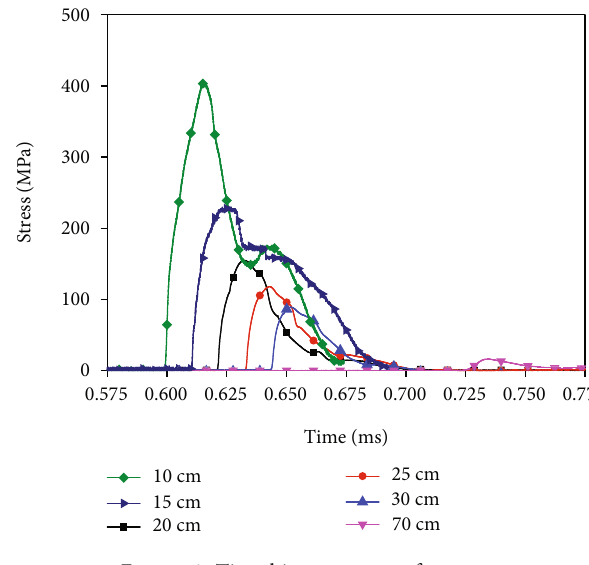
Figure 9: Time history curves of stresses.